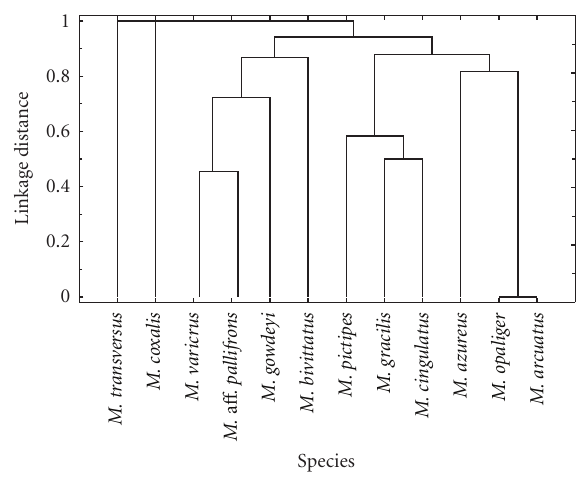
Figure 5: Cluster analysis of Merosargus species based on the similarity in resource use by the larvae from samples collected at the Parque Estadual do Rio Doce (PERD), Minas Gerais, Brazil, between October 2001 and October 2004. The cluster was constructed using the Jaccard distance (1 − J ) and the UPGMA amalgamation rule.